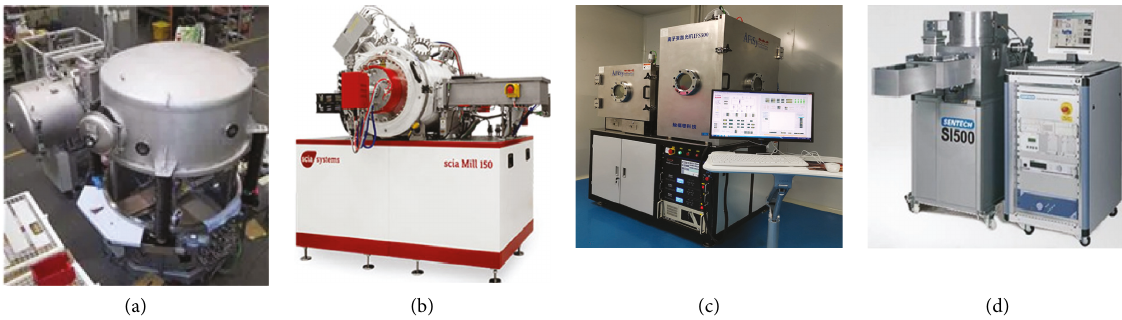
Figure 10: Ion beam polishing equipment. (a) NGT IBF-450. (b) SCIA mill 150. (c) AFiSy IFS300. (d) AJA